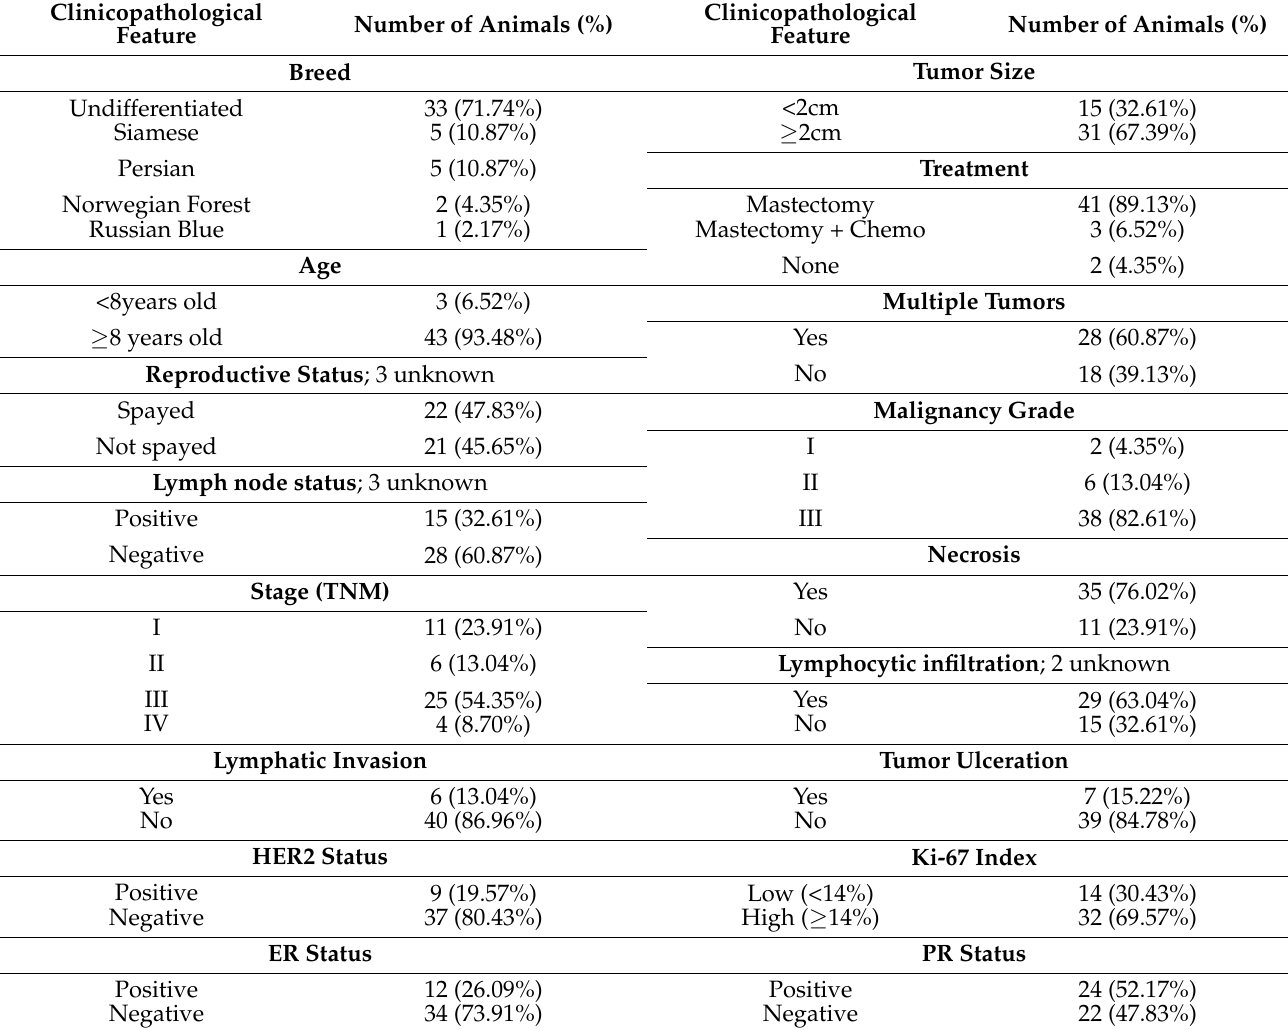
Table 1. Clinicopathological features of the 46 queens with mammary carcinomas enrolled in this study (TNM—Tumor, node, metastasis; ER—Estrogen receptor; PR—Progesterone receptor). Clinicopathological Number of Animals (%) Feature